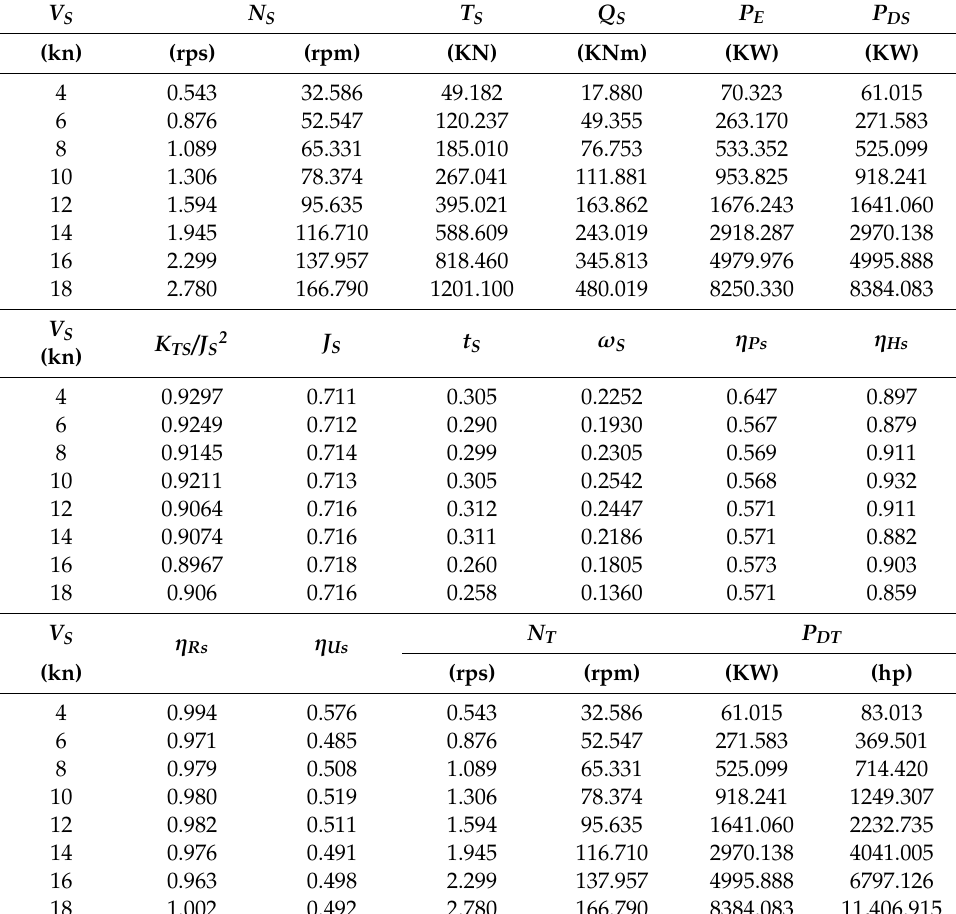
Table 4. Forecast results of full-scale ship